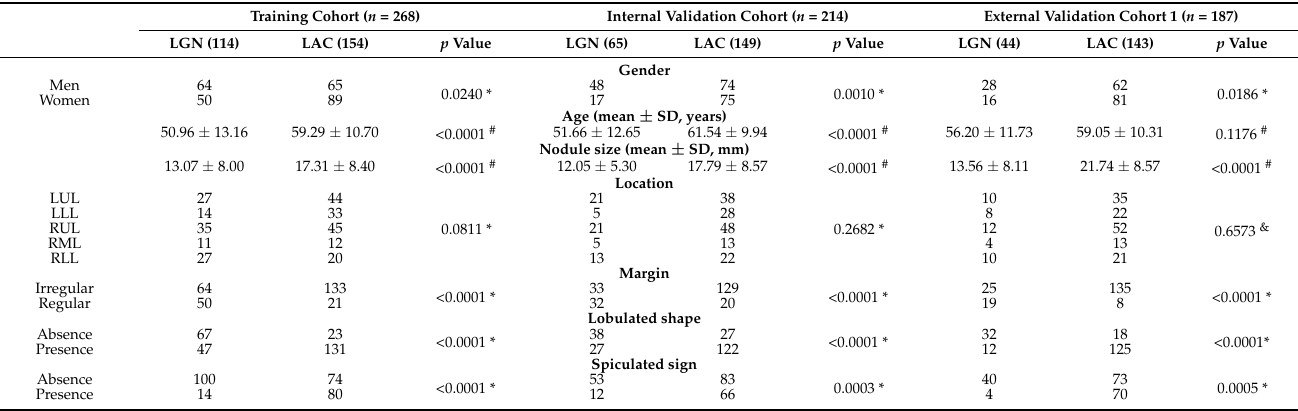
Table 2. Clinical factors and subjective CT findings from SPSNs in the LAC and LGN